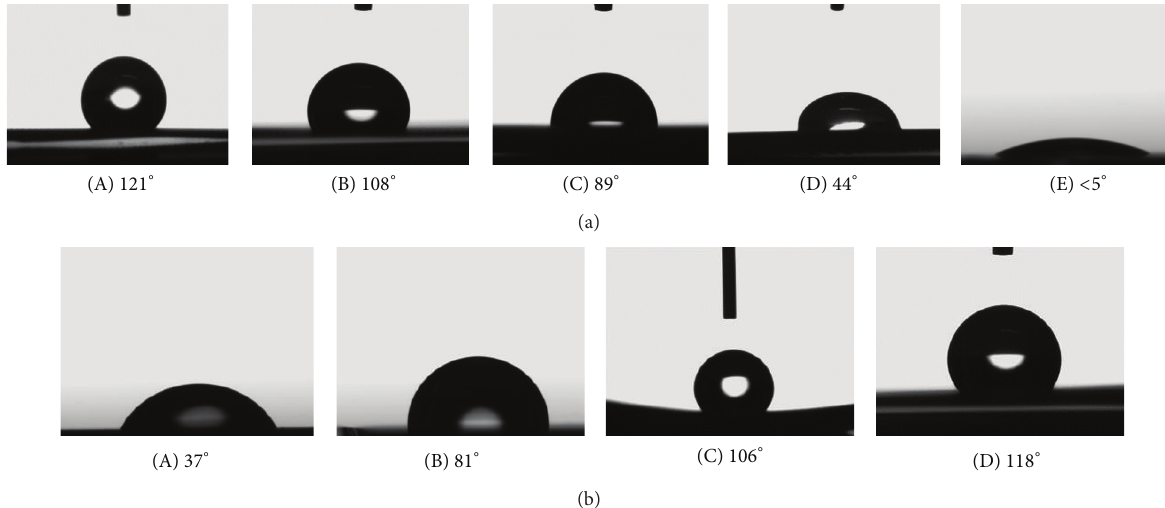
Figure 3: (a) Photoinduced superhydrophilicity followed by water droplet contact angle during light irradiation at times: (A) 𝑡 = 0 min, (B) 15min, (C) 30 min, (D) 45 min, and (E) 60 min. (b) Restoration of the hydrophilicity in the dark after times (A) 6 h, (B) 12 h, (C) 18h, and (D) 24 h.